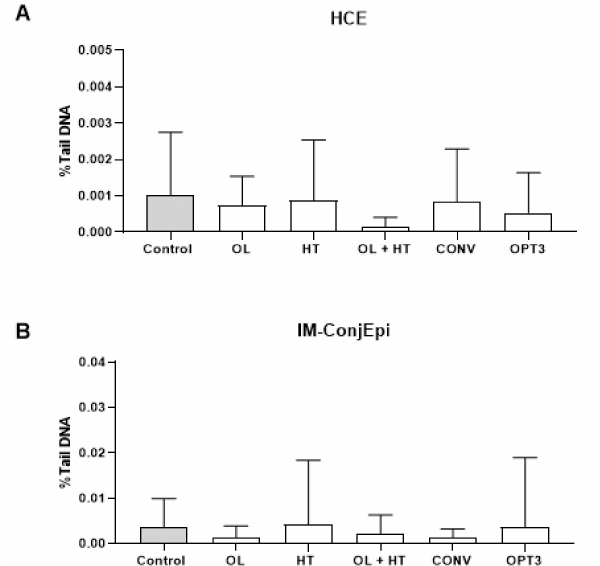
Figure 2. Genotoxic effect (alkaline comet assay) of aqueous solutions of olive pomace (OP) dried extracts (0.8 mg/mL conventional—CONV and 0.4 mg/mL optimized—OPT3), 300 µ M (162.2 mg/L) oleuropein (OL), 100 µ M (15.4 mg/L) hydroxytyrosol (HT) and their mixture (5 µ M/2.7 mg/L + 50 µ M/7.7 mg/L OL+HT) on human corneal (HCE) ( A ) and conjunctival (IM- ConjEpi) ( B ) epithelial cells treated for 24 h. No statistically significant differences have been observed between any of the treatment groups and the control group neither on HCE nor on IM-ConjEpi cells. Results are presented as mean of percentage of DNA present in the comet tail (%TDNA) ± standard deviation (SD). Control cells were treated with vehicle (culture